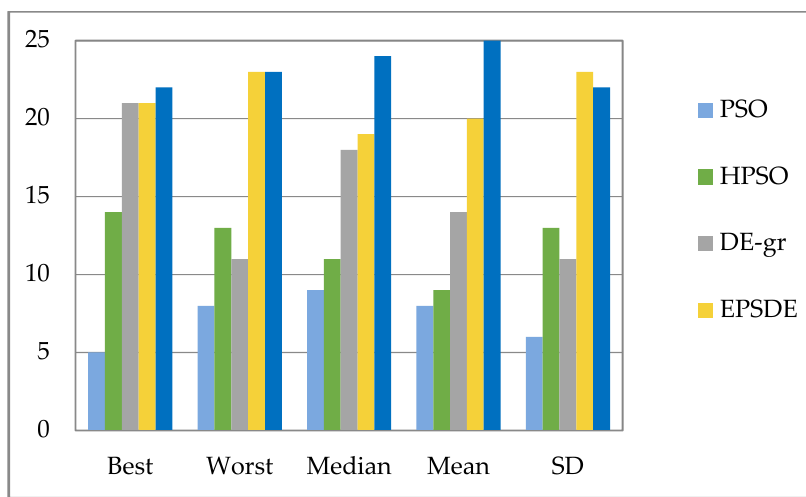
Figure 23. The statistical values of the five metaheuristic optimization methods.